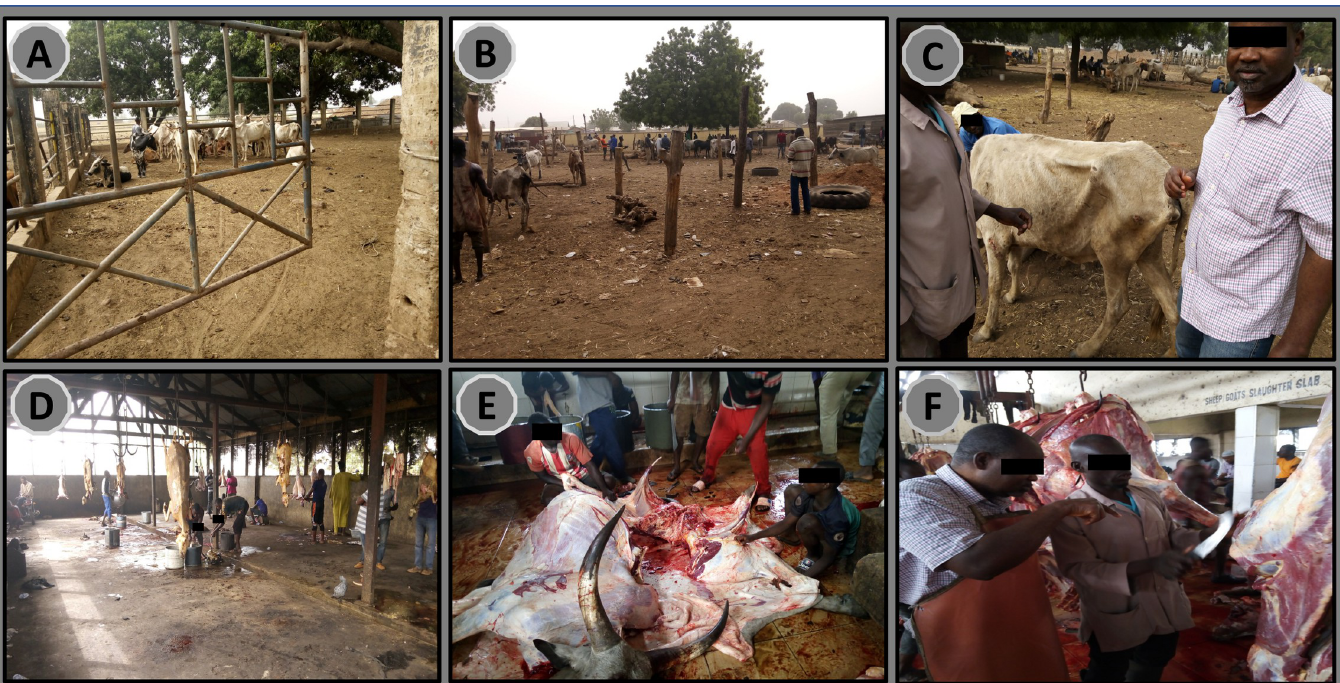
Fig 3. Activities at a typical abattoir. (A and B) lairage for cattle (C) ante-mortem inspection by a veterinary officer (D) slaughterhouse for small ruminant (E) slaughterhouse for large ruminant (F) Post-mortem inspection for macro lesions by a veterinary officer.